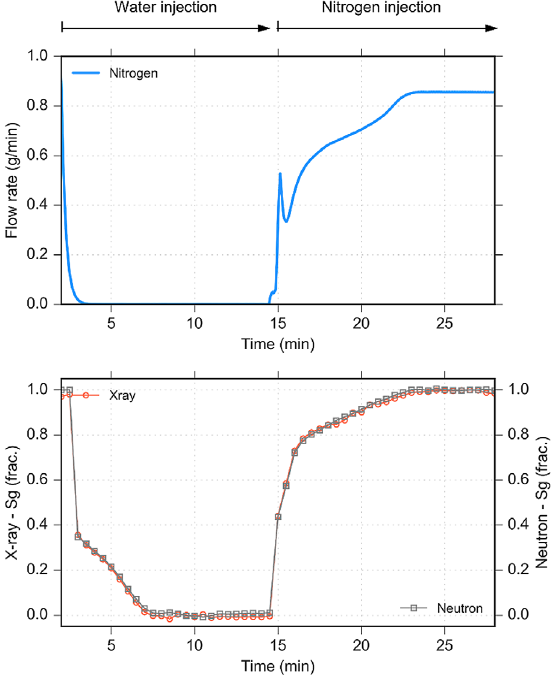
Fig. 3. Dry-out with deionized water. X-ray and Neutron beams are normalized between dry states and saturated with deionized water.